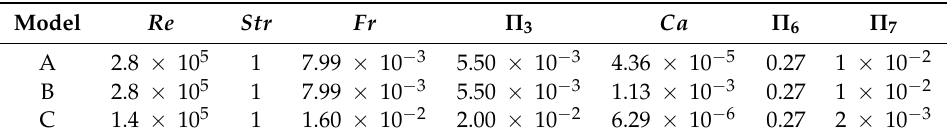
Table 2. Dimensionless